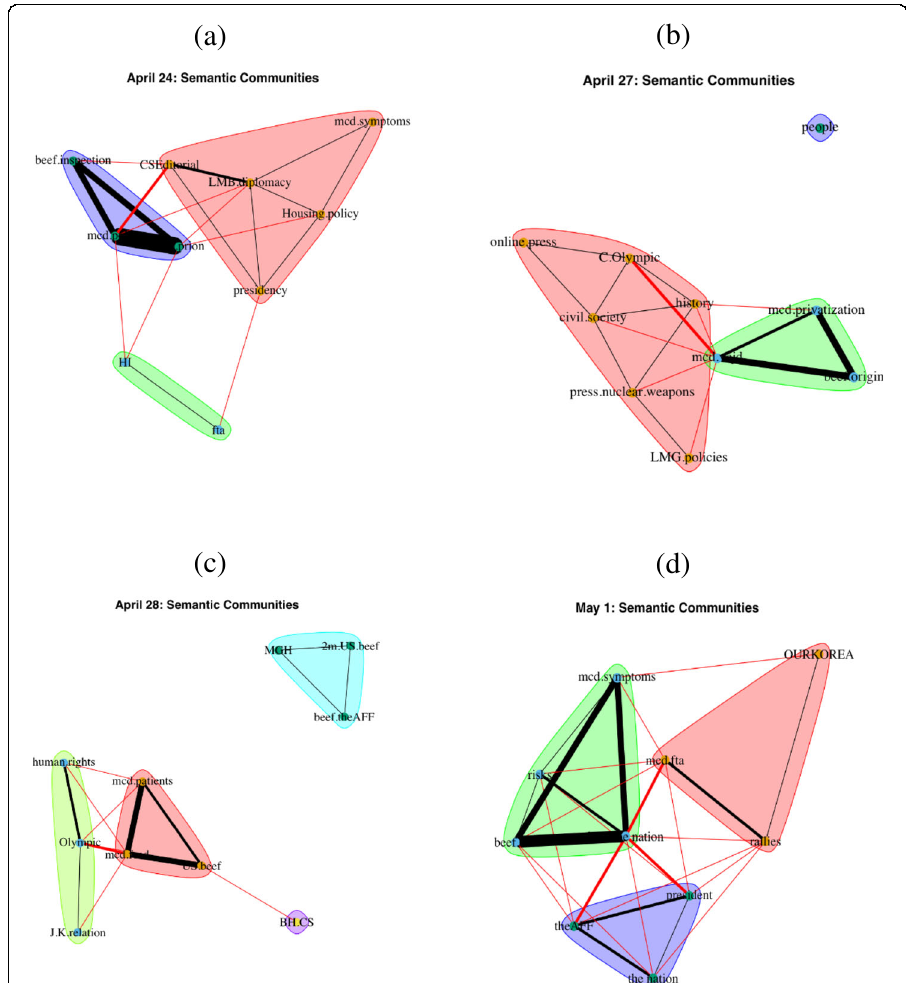
Fig. 4 Note: High modularity in topic networks. Note: These four networks of topics have modularity scores higher than 0.2. Red and black lines present respectively links within community and inter-community. High-modularity networks indicates that intracommunity ties are much stronger than inter-community